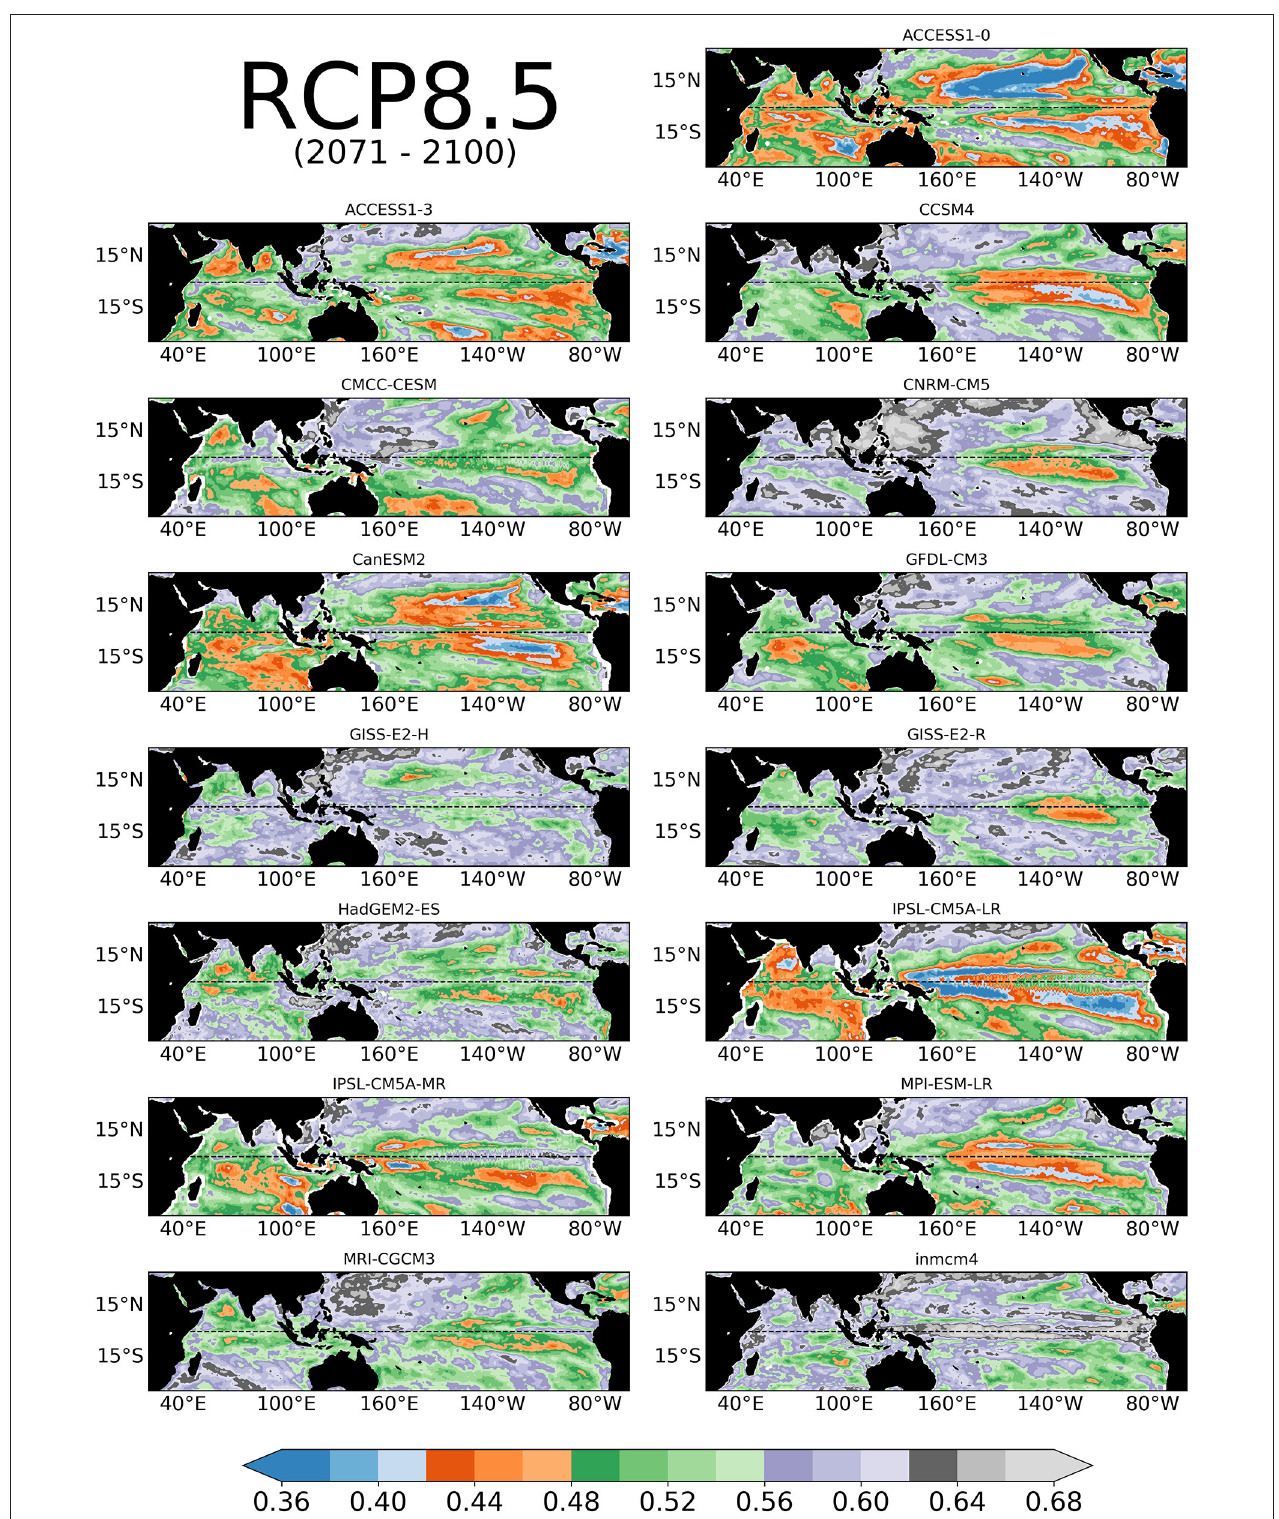
FIGURE 5 | Extended boreal fall (ASON) SST entropy fields with microstates, M = 3 for CMIP5 RCP8.5 runs used in this study. The model data span the period 2071–2100.